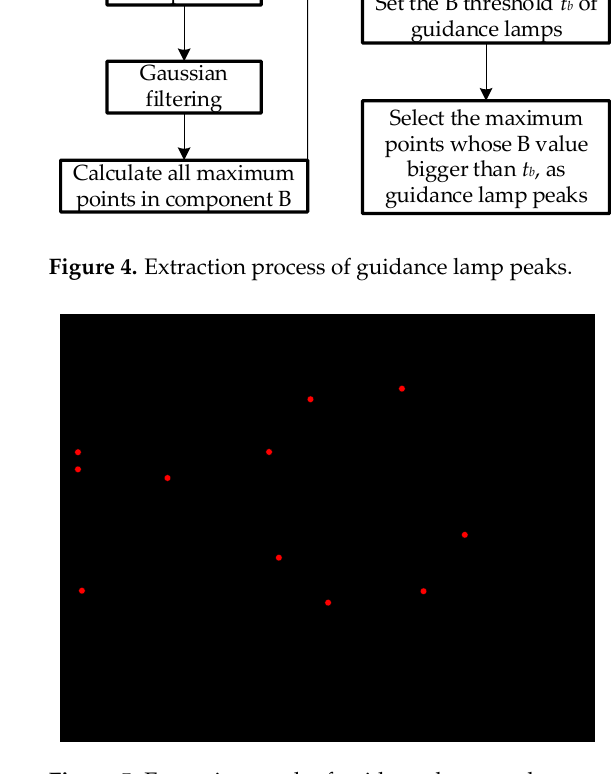
Figure 5. Extraction result of guidance lamp peaks.